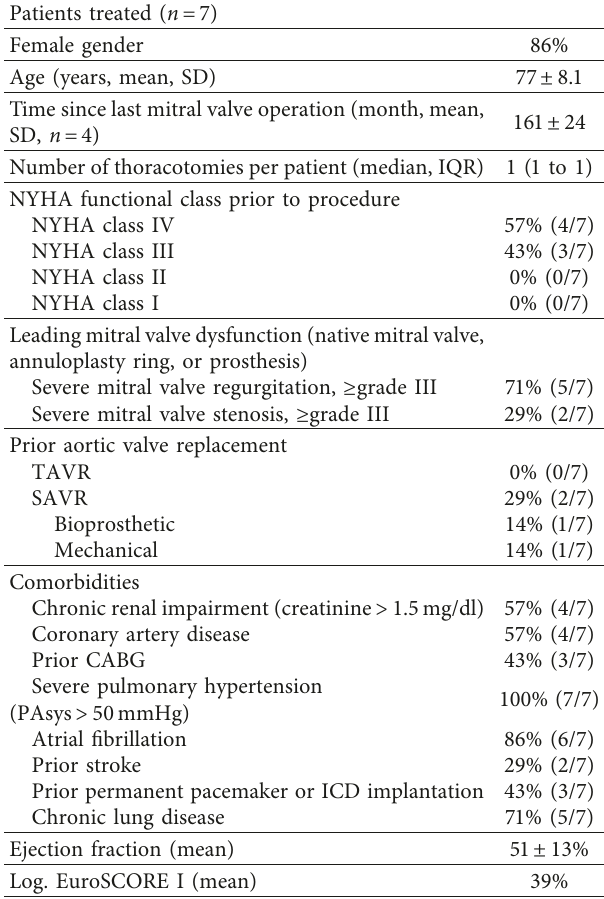
Table 1: Patient demographics and comorbidities. Patients treated ( n �